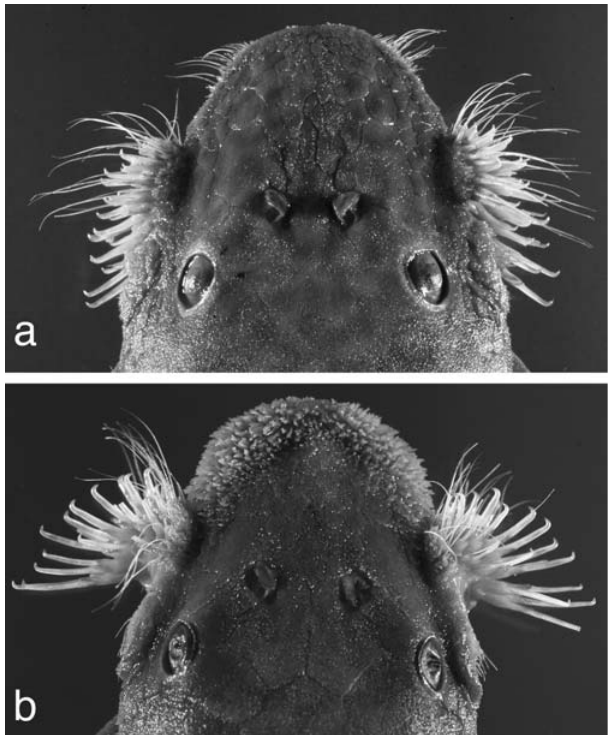
Fig. 2. Heads, dorsal view showing whiskerlike odontodes on cheek (a and b), whiskerlike odontodes on snout (a) and tentacules on snout (b) a. Lasiancistrus guacharote , ANSP 128695, 123.4 mm SL, b. Lasiancistrus tentaculatus , INHS 28650, 105.5 mm